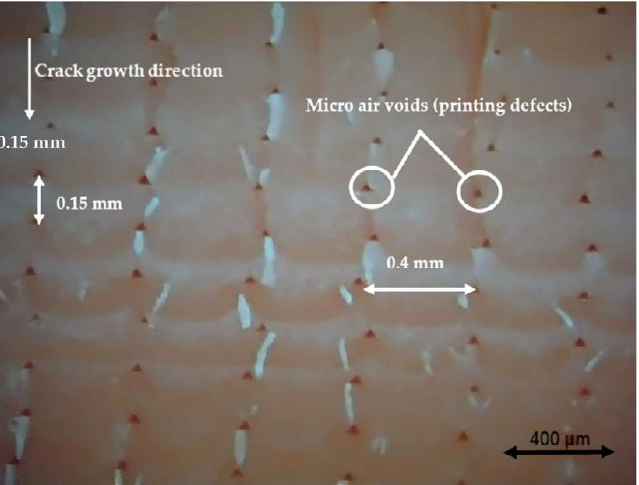
Figure 7. Formation of internal holes (microvoids) during FFF printing of an ABS specimen. Bright lines show the path of microcracks initiated from internal holes (stress concentration areas) [35]. CC BY 4.0.